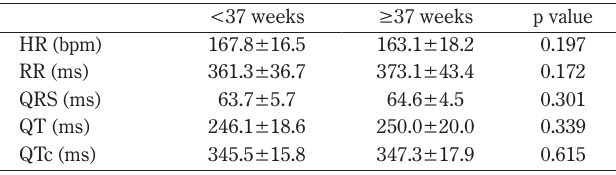
Table 2 Electrocardiogram characteristics stratified by gestational age